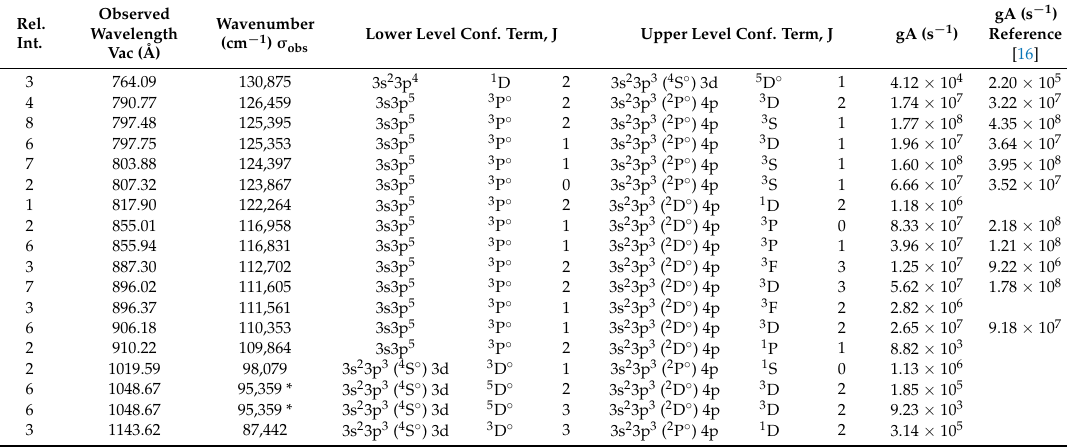
Table 3. New classified lines of Ar